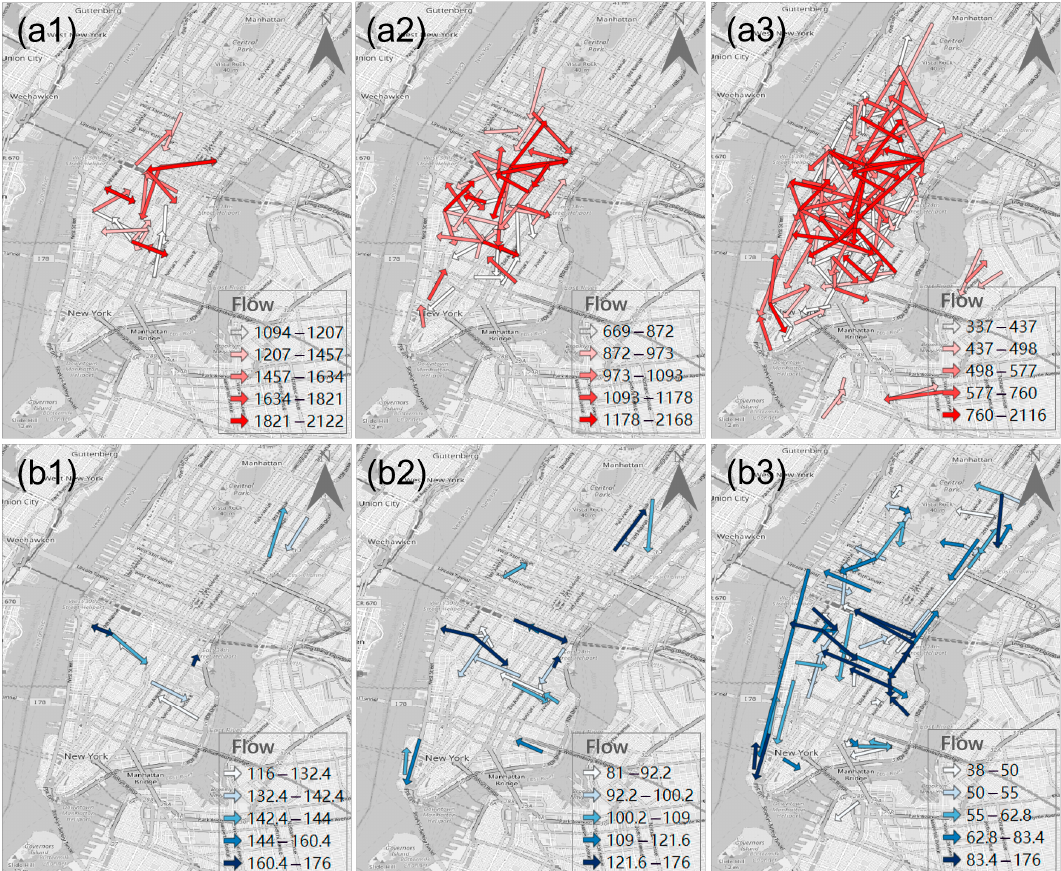
Figure 13. The clustering results of different et represented by core edges ( a1 ) 2019 et = 115; ( a2 ) 2019 et = 77; ( a3 ) 2019 et = 38; ( b1 ) 2020 et = 15; ( b2 ) 2020 et = 10; and ( b3 ) 2020 et = 5.